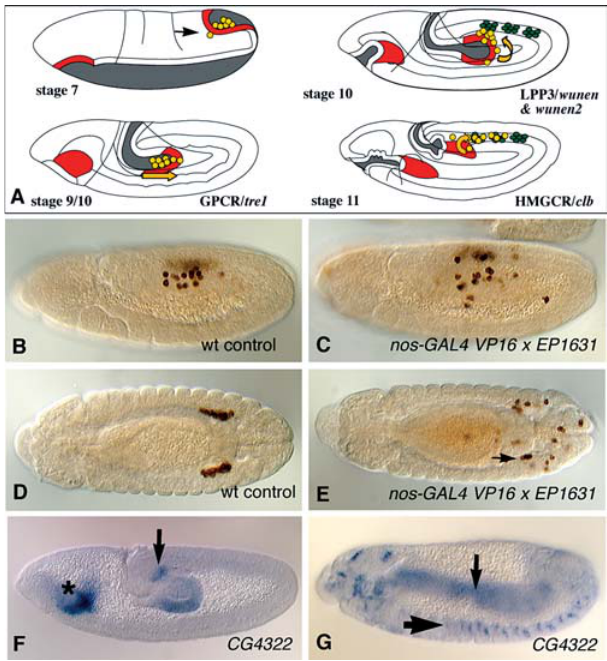
Figure 1. A Summary of Early Germ Cell Migration Steps and Genes (A) For each stage, the position of germ cells (yellow) and midgut (red) is indicated. Yellow arrows point in the direction of migration. Note that in wild-type embryos, few germ cells can be observed on the basal side of the midgut anlage (black arrow, stage 7). Genes known for their specific role in germ cell guidance are indicated next to the step where the activity of the respective gene product is needed. In addition to the genes listed, a role for hedgehog has been suggested in germ cell migration (Desphpande et al. 2001); however, the exact step affected is unclear. (B–G) Overexpression of EP1631 in germ cells and expression pattern of CG4322 . Anterior is to the left in all panels. (B), (C), (F), and (G) are lateral views; (D) and (E) are top views. Wild-type embryos (B and D) and embryos overexpressing EP1631 ( CG4322 GPCR) in germ cells (C and E) were stained with anti-Vasa to mark germ cells. At stage 11 (B and C), germ cells in the wild-type (B) associate with the mesoderm, while germ cells expressing EP1631 ( CG4322 GPCR) using the germ cell-specific nos-GAL4 driver are disorganized (C). When the gonads are normally coalescing at stage 13 in wild-type control embryos (D), many germ cells expressing the CG4322 GPCR remain lost and are found in ectopic locations (E; arrow points to few germ cells in gonad). (F and G) Expression pattern of CG4322 RNA. CG4322 RNA is detected in hemocytes (asterisk), in the caudal visceral mesoderm (arrow), and in the PMG at stage 9 (F) and in midgut (arrow) and glial cells (arrowhead) at stage 13